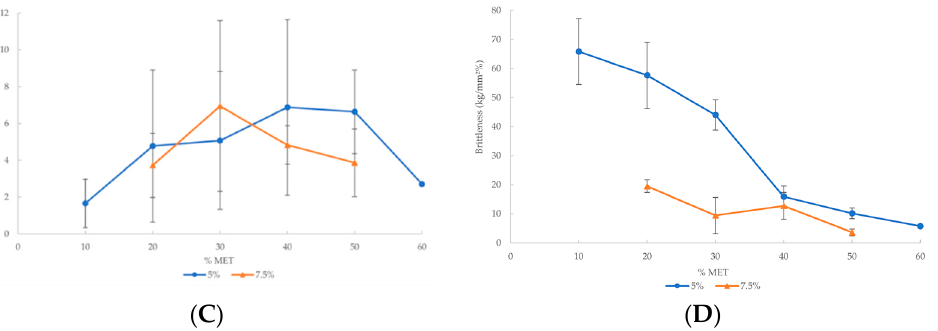
Figure 1. Graphical representation of the extrusion process parameters and filament parameters versus drug percentage of each filament with 5% or 7.5% auxiliary excipients: ( A ) residence time; ( B ) flow speed; ( C ) Df; ( D ) brittleness.